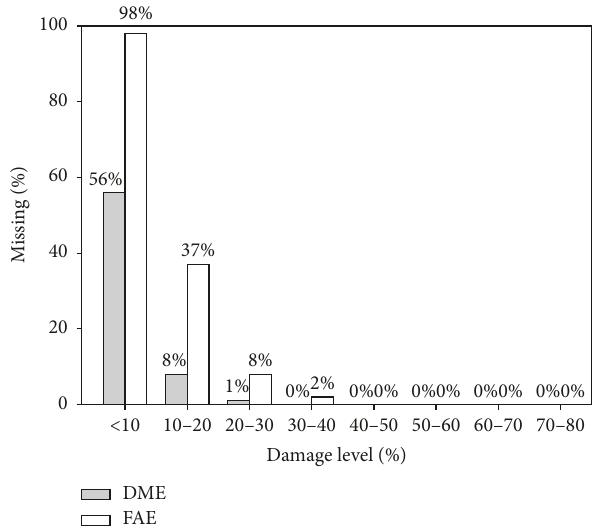
Figure 20: DME and FAE versus damage level for structural beam using model